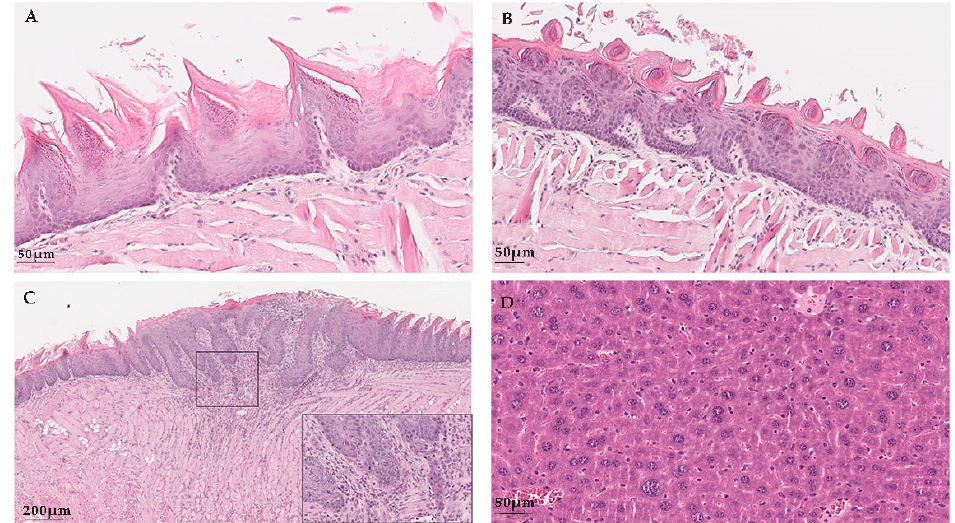
Figure 2. Histological findings of WT and MUT tongue and oral cancer. Legend: Histological samples from wild-type and transgenic K14HPV16 mice stained with H&E. ( A ) low power view of normal squamous cell epithelium of the tongue from a wild-type mouse; ( B ) low power view of mild dysplastic squamous cell epithelium with enlarged hyperchromatic nuclei in the upper layers of the epithelium from a transgenic K14HPV16 mouse and ( C ) low power view of a focally invasive squamous cell carcinoma with thickened rete ridges and dysplastic cells with hyperchromatic nuclei, irregular basement membrane and focally disrupted associated with inflammatory cells in the stroma from a transgenic K14HPV16 mouse; the inset shows the invasive front. ( D ) low power view of the liver of one transgenic K14HPV16 mouse showing normal structure and cytology.